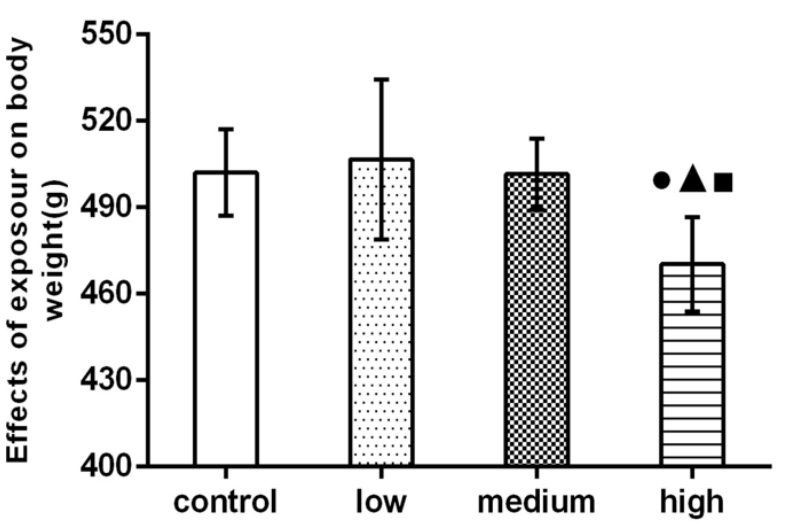
Figure 2. Effect of La 2 O 3 NPs on rat body weight. Note: ● , compared with the control group, p < 0.05; ▲ , compared with the low group, p < 0.05; ■ , compared with the medium group, p < 0.05. The body weight of the high-dose group was significantly higher than that of the control group and the low-dose and medium-dose groups ( p < 0.05).